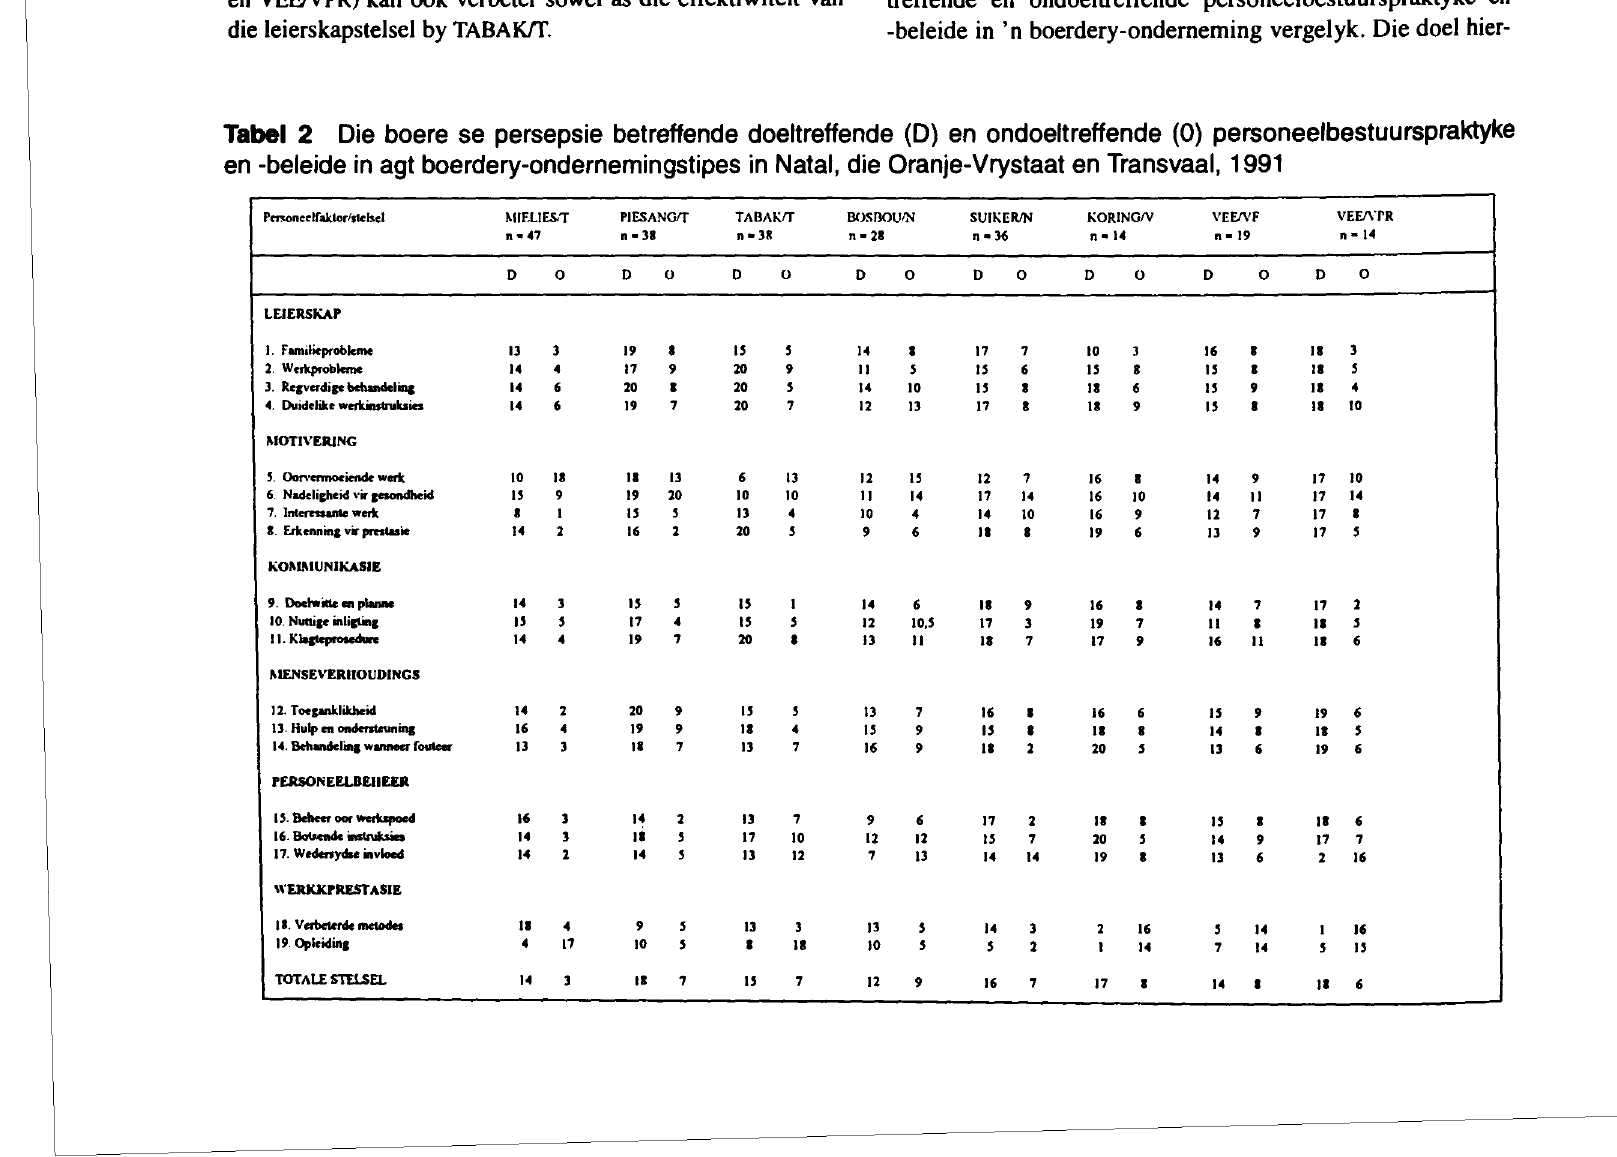
Tabel 2_ D!e boere se persepsie betreffende doeltreffende (D) en ondoeltreffende (0) personeelbestuurspraktyke en -bele1de in agt boerdery-ondernemingstipes in Natal, die Oranje-Vrystaat en Transvaal,